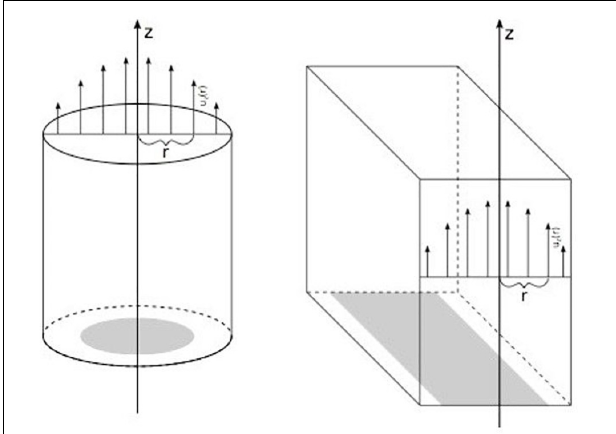
FIGURE 10 | Sketch of the geometries investigated in the analysis of conduit residence times and the velocity profiles. For both geometries, r denotes the distance from the vertical